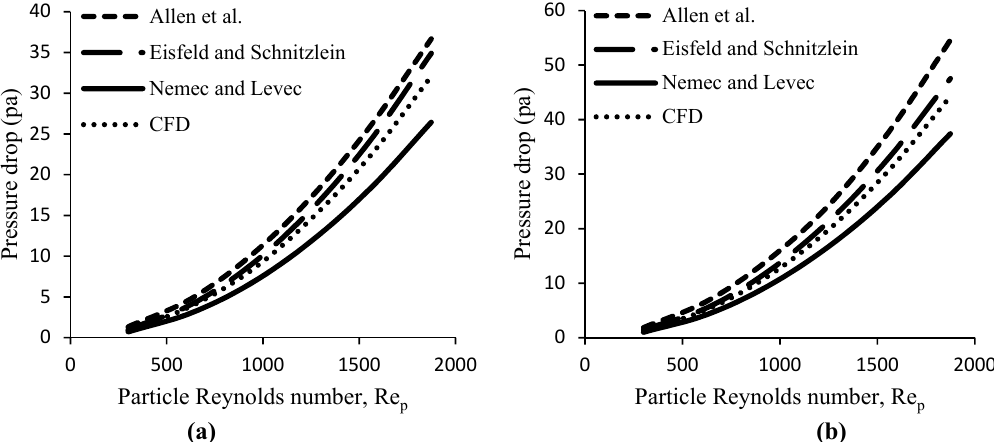
Fig. 9. Comparison of CFD pressure drop with empirical correlations for the packed bed with cone particles in turbulent flow: a) N=7.82 and b)